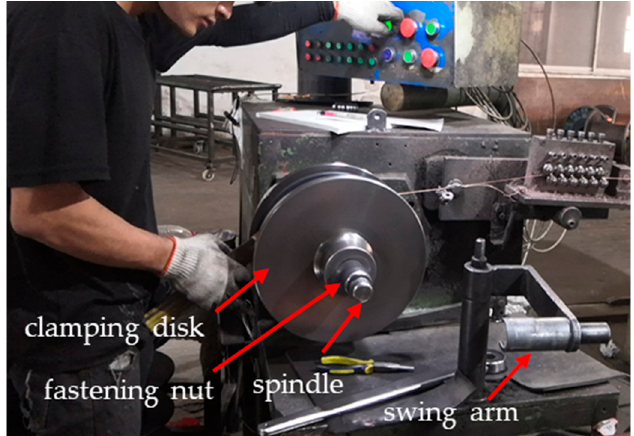
Figure 1. Manual operation of welding wire winding. The spool is installed onto the spindle, clamped by the clamping disk, and fastened by a nut. A swing arm is applied to assist the worker to load and unload the clamping disk.